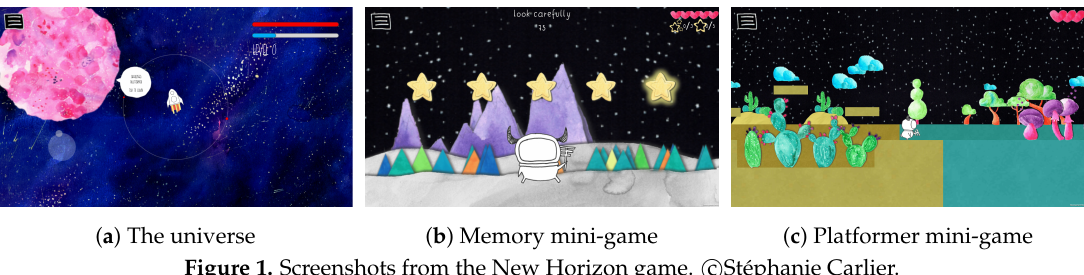
Figure 1. Screenshots from the New Horizon game. c (cid:13) Stéphanie